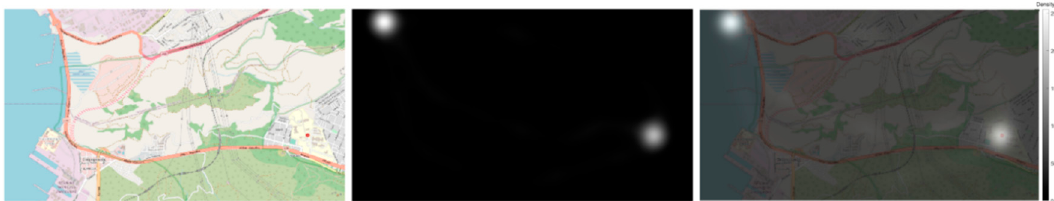
Figure 9. Grayscale statistical heatmap output (center) referred to all mouse movement data produced during the visual search process in the second visual stimulus (left). On the right the produced ground truth is superimposed on top of the viewed stimulus.